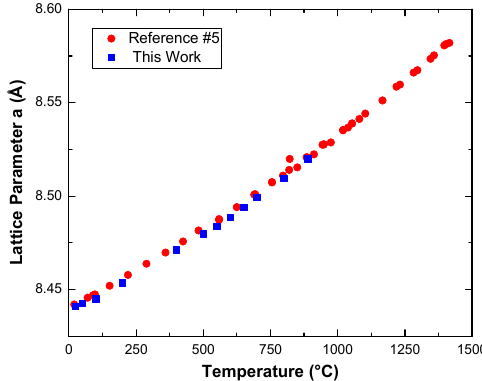
Figure 2. Lattice parameter a of the reference Mg 2 TiO 4 material versus temperature from HT-XRD of sample GQ in comparison to reported HT-ND data [5].